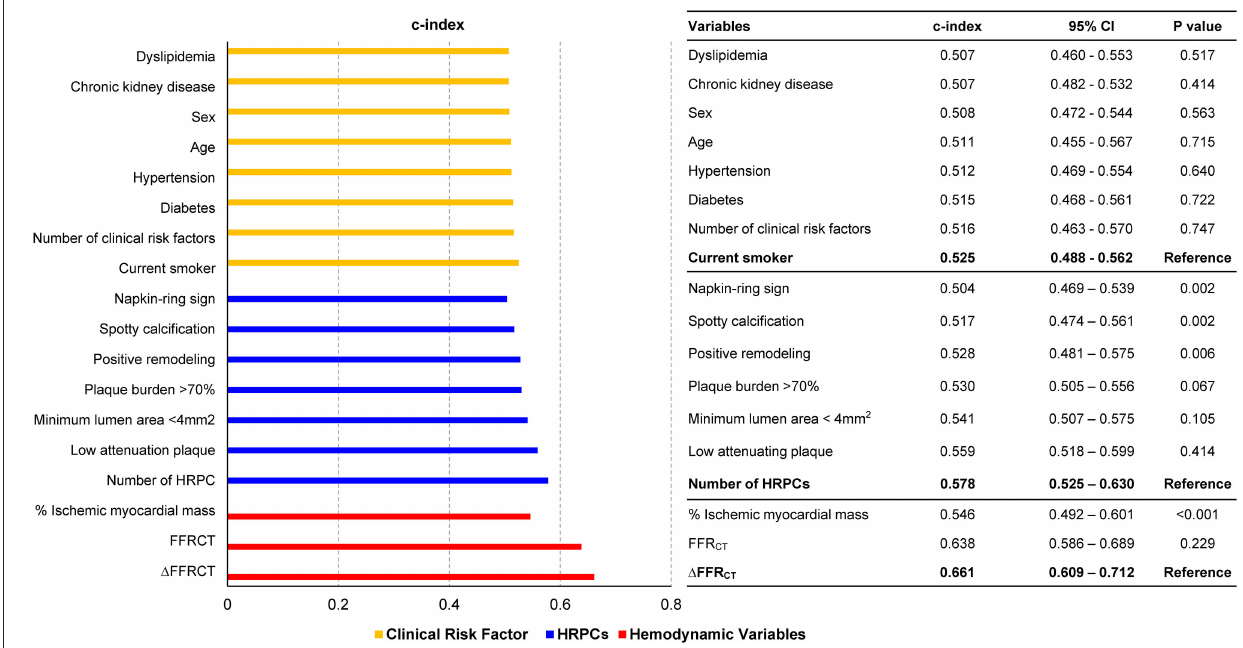
FIGURE 2 | Comparison of discrimination abilities of clinical risk factors, HRPCs, and hemodynamic parameters for subsequent coronary events. Discrimination abilities of clinical risk factors (green bar), HRPCs (blue bar), and hemodynamic parameters (red bar) for subsequent coronary events are presented as c-index and 95% CI. For various variables in each group, the c-index comparison was performed with the variable with the highest c-index in each group. CI, confidence interval; FFR CT , fractional flow reserve by coronary computed tomography angiography; HRPCs, high-risk plaque